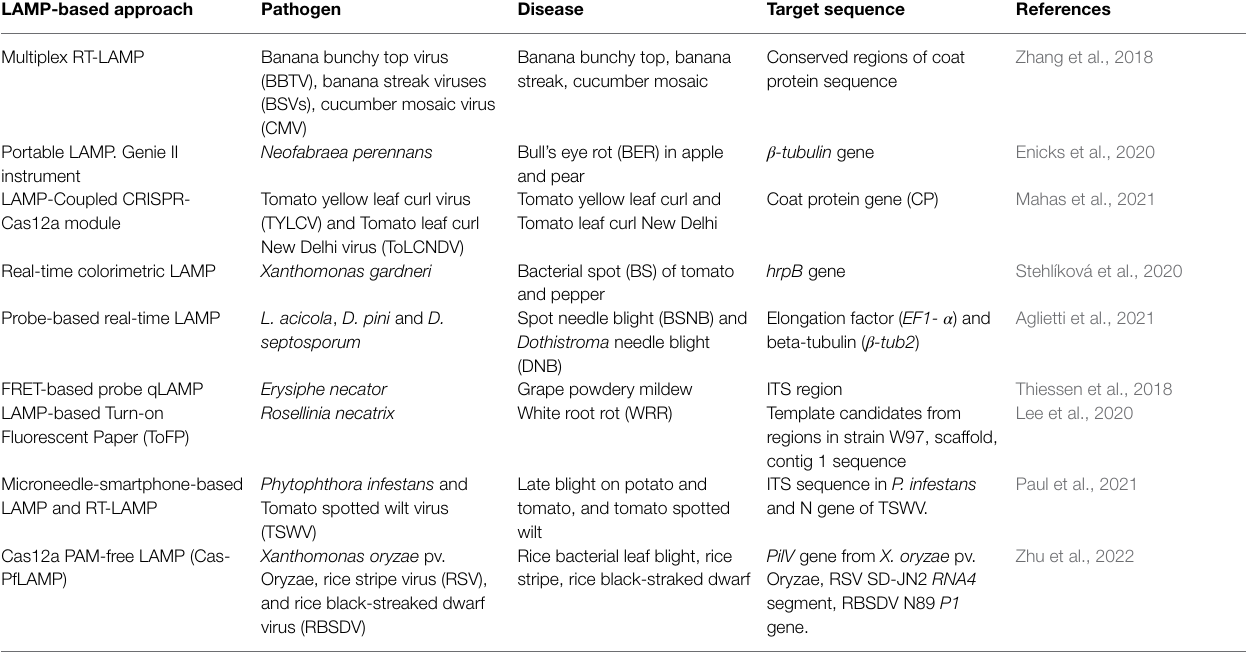
TABLE 3 | Recent LAMP-based approaches for detection of pathogens in other plants. LAMP-based